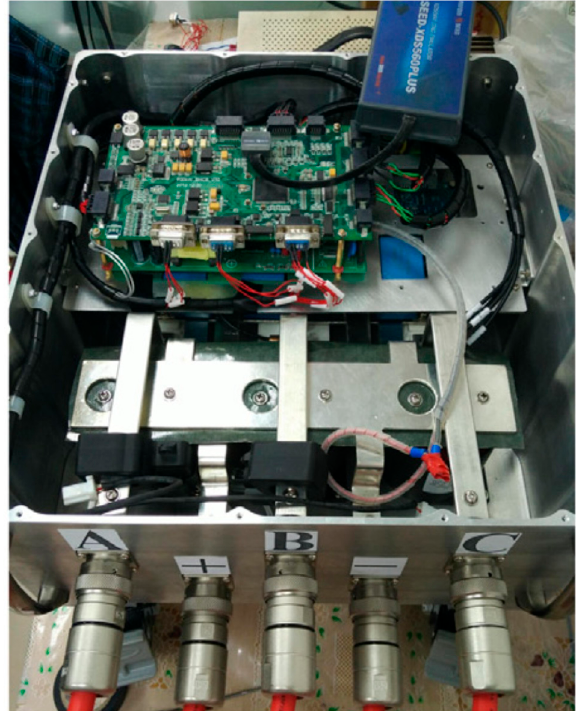
Figure 12. SiC-MOSFETs-based inverter for a PMSM drive system. Table 7. Fitting coefficients of the SiC-MOSFET modules.